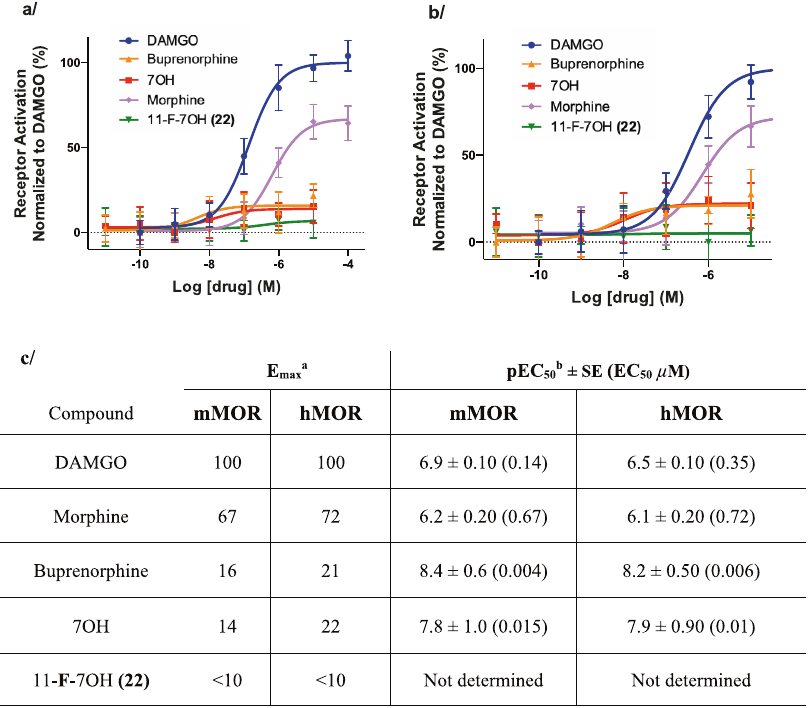
Fig. 7 Receptor activation by 7OH series in comparison to known opioids in BRET-based Nb33 recruitment assay at mMOR and hMOR. Intrinsic receptor activation ef fi cacy was determined by the extent of recruitment of the conformationally selective nanobody Nb33 to hMOR or mMOR fused as its C terminus to NanoLuc, as measured by BRET. Positive controls used are: DAMGO, buprenorphine, morphine, and parent 7OH. a Agonist activity of 11-F-7OH ( 22 ) as compared to positive controls at mMOR. b Agonist activity of 11-F-7OH ( 22 ) as compared to positive controls at hMOR. Curves represent the average of n = 3, independent experiments with error bars representing ±SEM. c Functional activity of 11-F-7OH ( 22 ) and positive controls at mMOR and hMOR in Nb33 BRET Assay [ a Agonist activity indicated by EC 50 values, maximal ef fi cacy is expressed relative to DAMGO ( E max ). b All data points represent − logEC 50 ± SE (EC 50 µ M) for n = 3 repetitions].